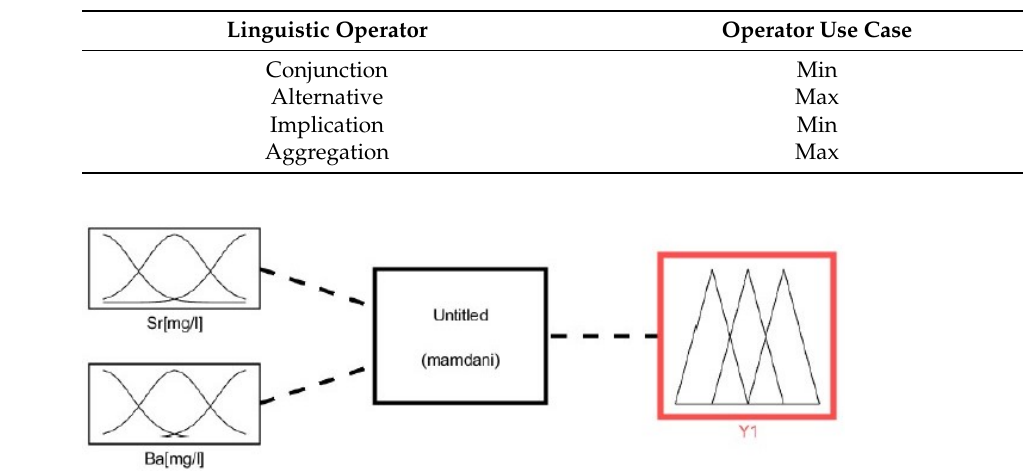
Table 6. Application of linguistic operators during the process of fuzzy inference.